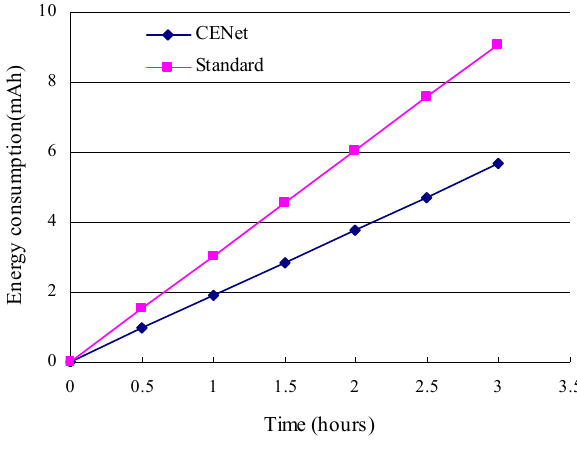
Figure 12. Energy consumption of CENet and standard stack.